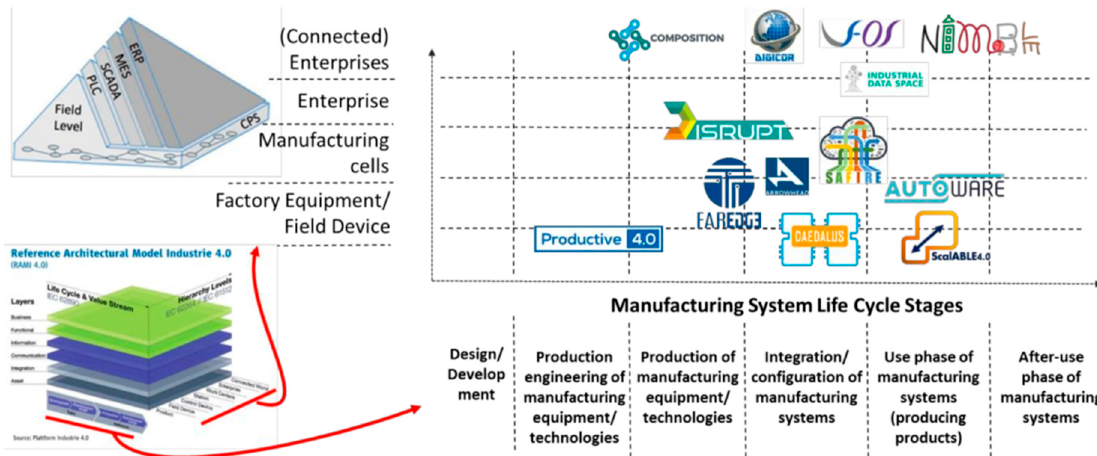
Figure 1. Positioning of digital platform related research and development (R&D) projects on RAMI 4.0. Source Reference [43] (p.